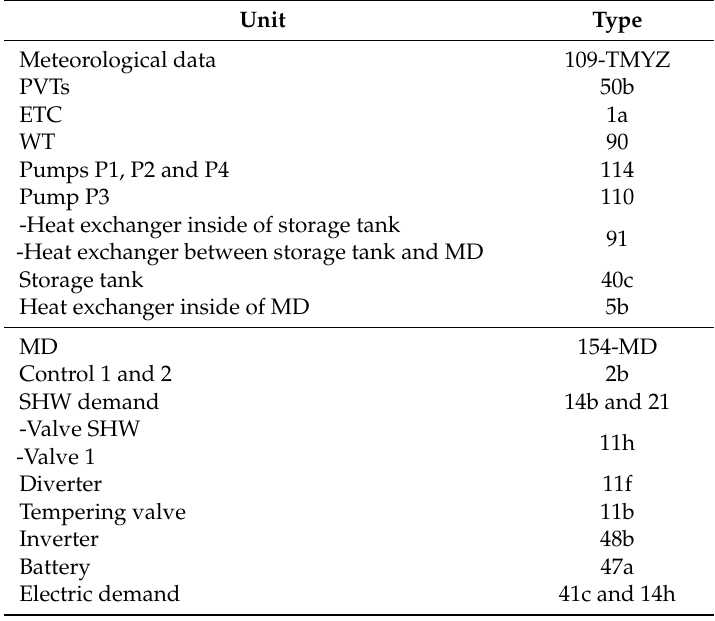
Table 5. Units and Types simulated in TRNSYS ®